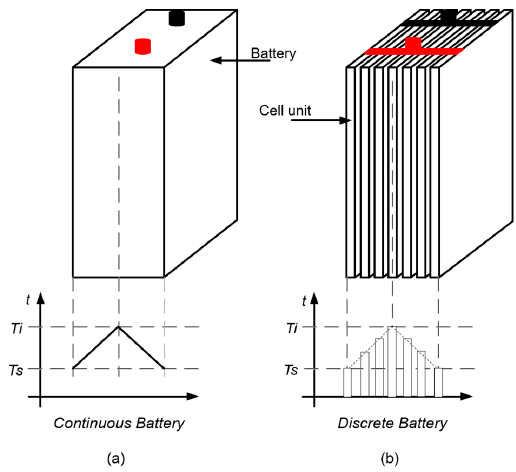
Figure 3. Diagram of battery discretization: ( a ) continuous battery; ( b ) discrete battery.